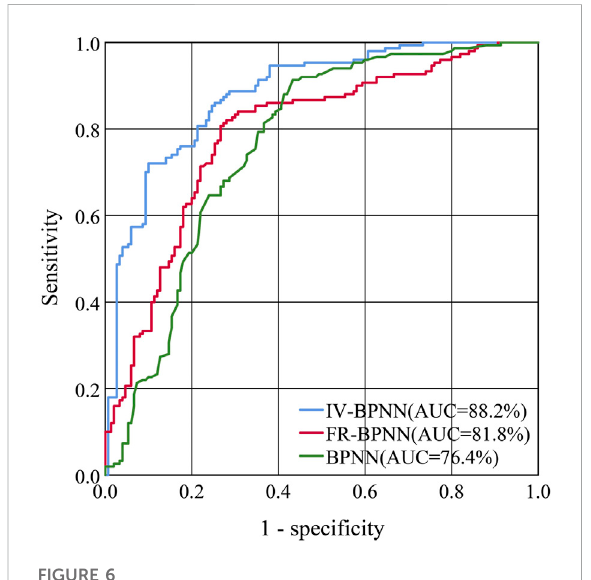
FIGURE 6 ROC curve of landslide susceptibility